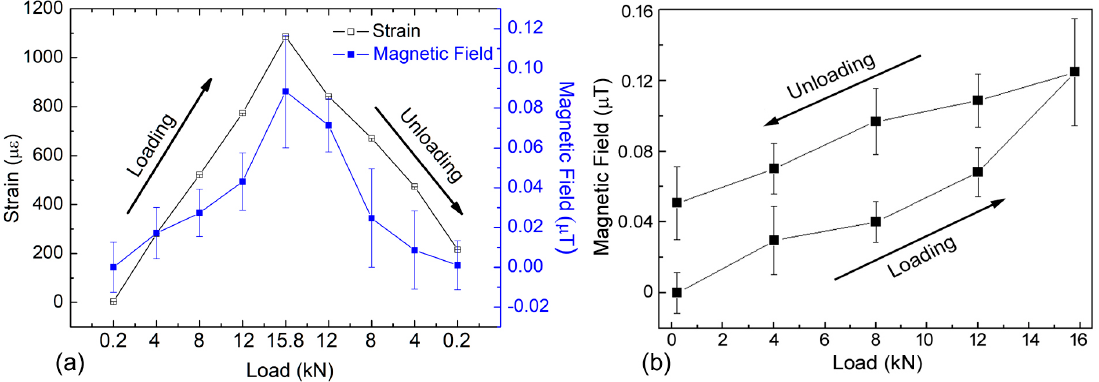
Figure 9. ( a ) Comparison between the strain gage signal (left scale) and the magnetic field (right scale) detected by GMR gradiometer during the load and unload test from 0.2 kN to 15.8 kN; ( b ) detailed of the magnetic field detected by GMR gradiometer during the loading cycle up to 15.8 kN in its properly x-axis scale.